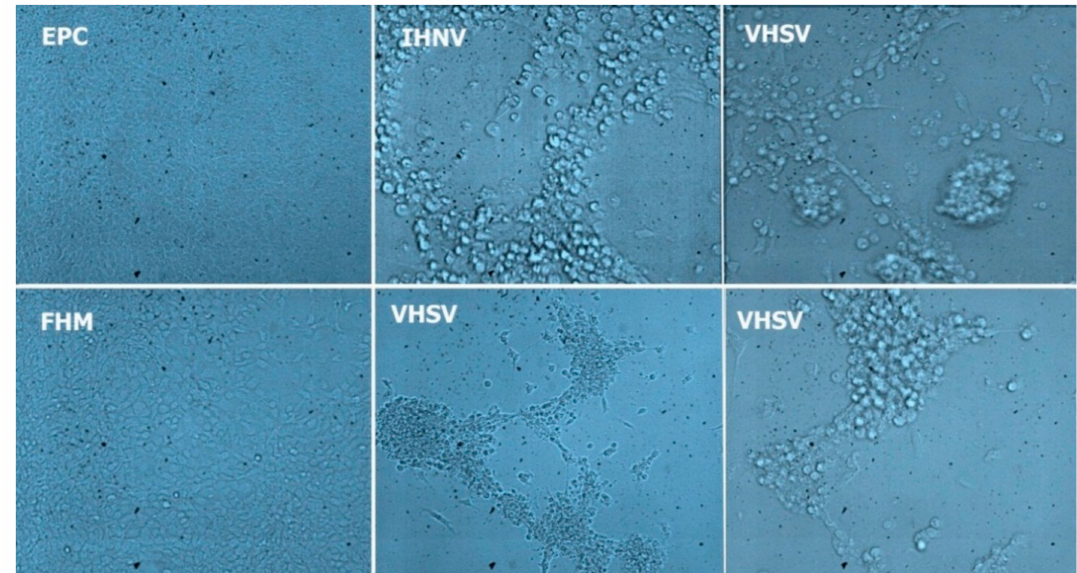
Figure 1. Cytopathic effect (CPE) caused by Viral hemorrhagic septicemia virus and Infectious hematopoietic and necrosis virus (VHSV and IHNV) in EPC and FHM cell lines at different days post-inoculations (dpi). The upper row shows control uninfected EPC cells (40 × ), IHNV, and VHSV infected EPC cells showing CPE at 5 dpi (100 × ). The bottom row shows FHM control cells (40 × ) and infected FHM cells with VHSV at 5 dpi (40 × and 100 × ,